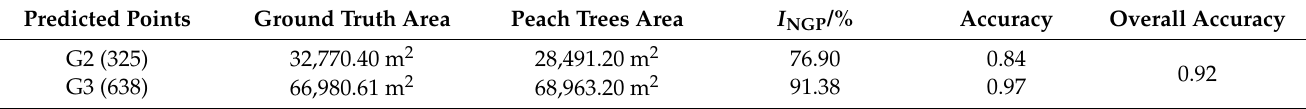
Table 3. The estimated peach trees area is in the projection plots.